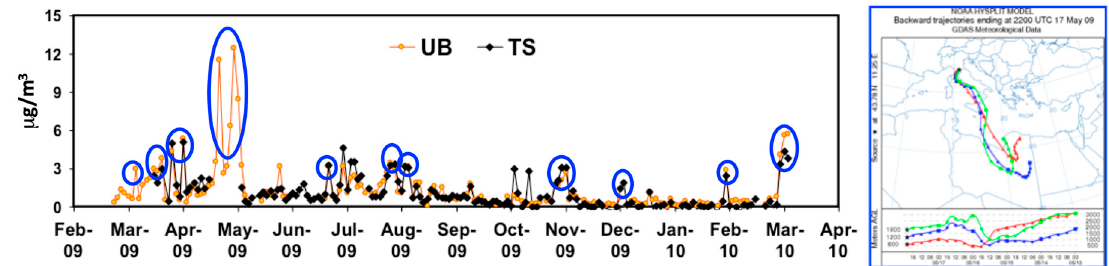
Figure 8. Daily contributions of the mineral dust source: Days identified as Saharan intrusions on the basis of calculated backward trajectories (HSDs) are highlighted by blue circles. As an example, the HYSPLIT chart corresponding to the most intense peak is reported.